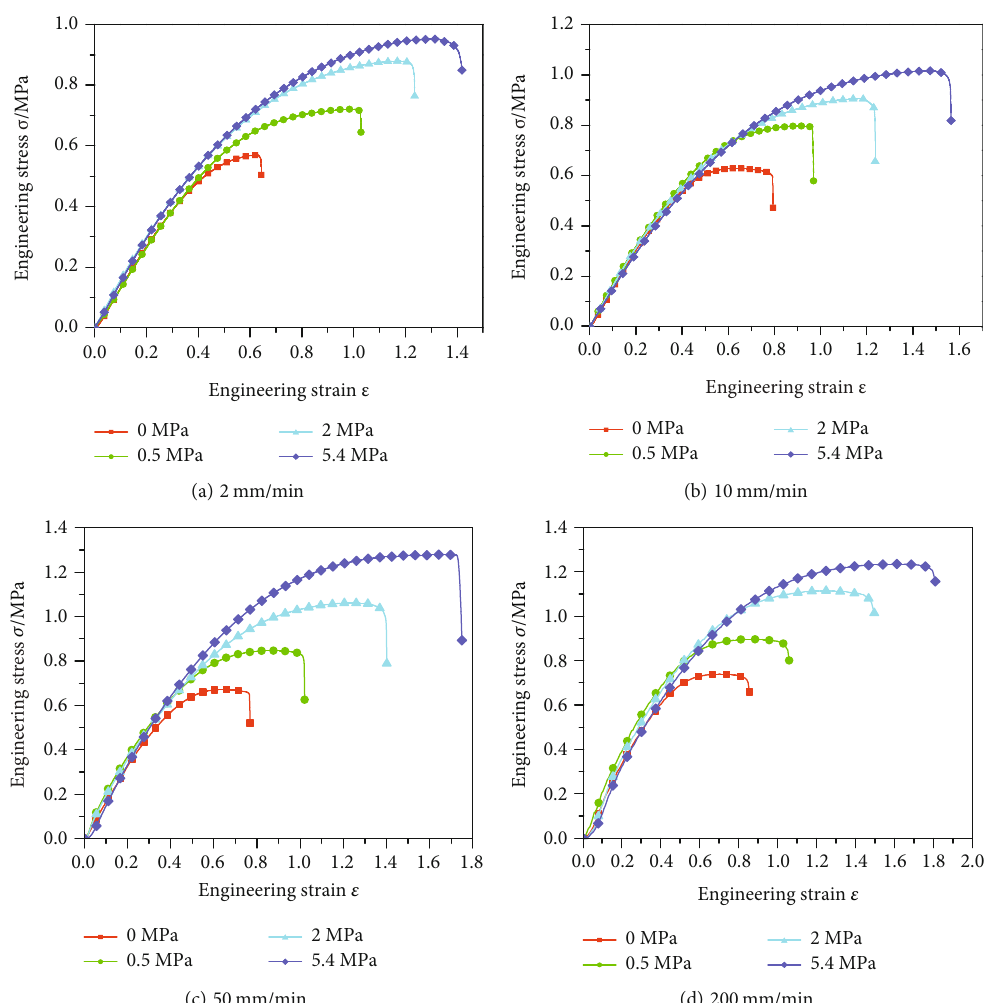
Figure 6: Stress-strain curves of N15 propellant under di ff erent con fi ning